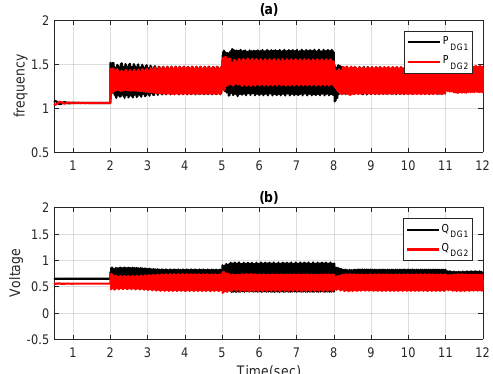
Figure 19. Dynamic response of DG units to unbalanced load changes in feeder F 1 and F 3 : ( a ) real power, and ( b ) reactive power components of DG